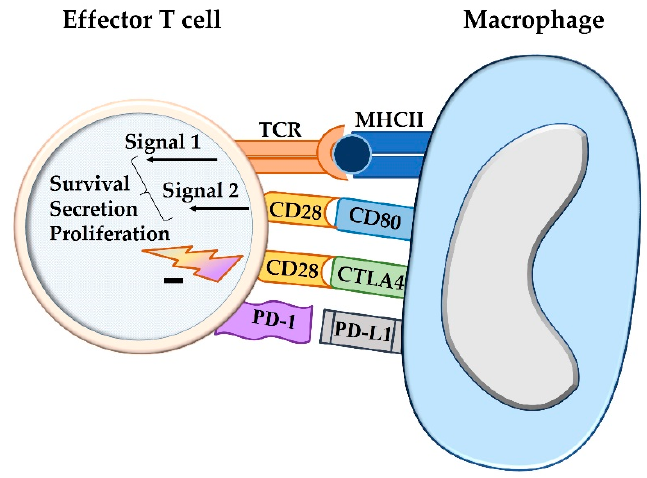
Figure 1. The activation state of a T cell, i.e., cytokine production, proliferation, and overall survival, is not only influenced by co-stimulation, but also by concurrent inhibitory signals. The two-signal hypothesis refers to the antigen presentation by major histocompatibility complex I or II molecules of an antigen-presenting cell that causes antigen priming of the T cell receptor (signal 1). For activation of a T cell, co-stimulation through ligation of CD80 or CD86 with CD28 is required (signal 2). The degree of the activation, however, can be further modulated by additional stimulatory or inhibitory signals. The latter are mediated by CTLA4, which competes with CD80/CD86 for CD28 binding, and by the interaction between PD-L1 and PD-1, both acting as immune checkpoint molecules. TCR = T cell receptor; MHCII = major histocompatibility complex II; CTLA4 = cytotoxic T-lymphocyte-associated protein 4; PD-1 = programmed cell death protein 1; PD-L1 = programmed death-ligand 1.